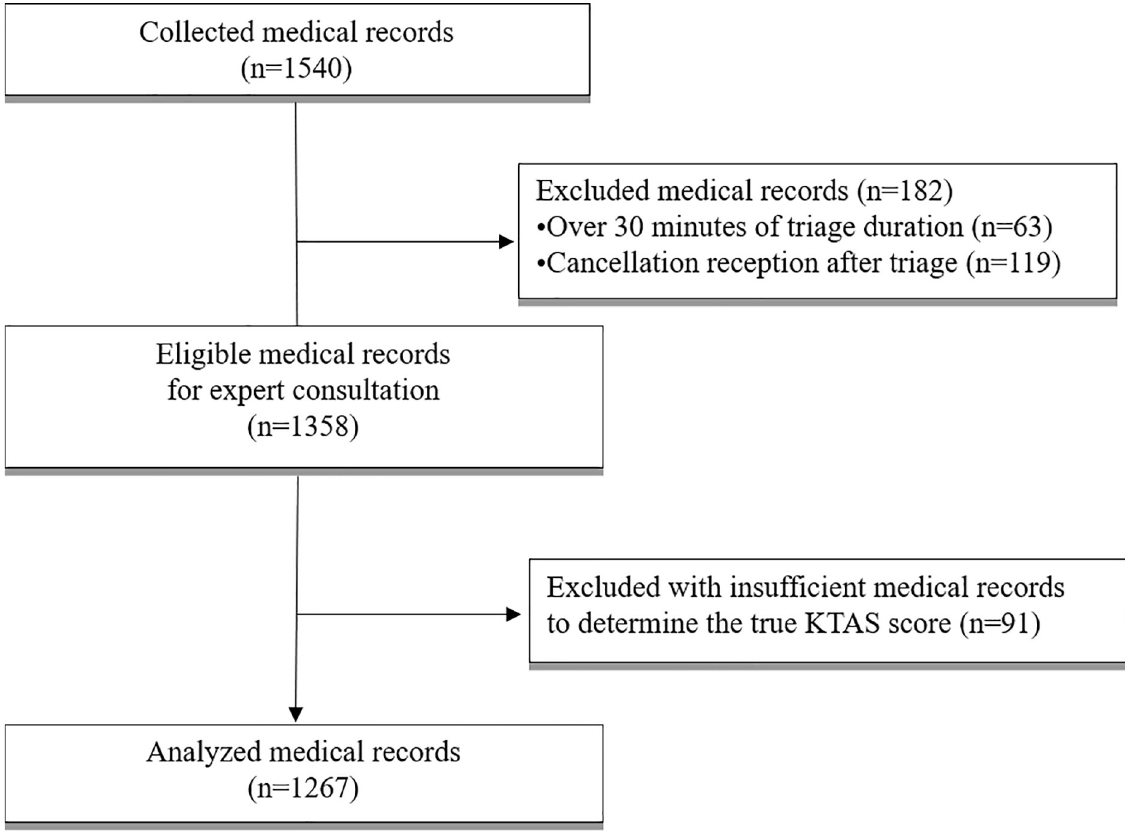
Fig 2. Flow chart of study